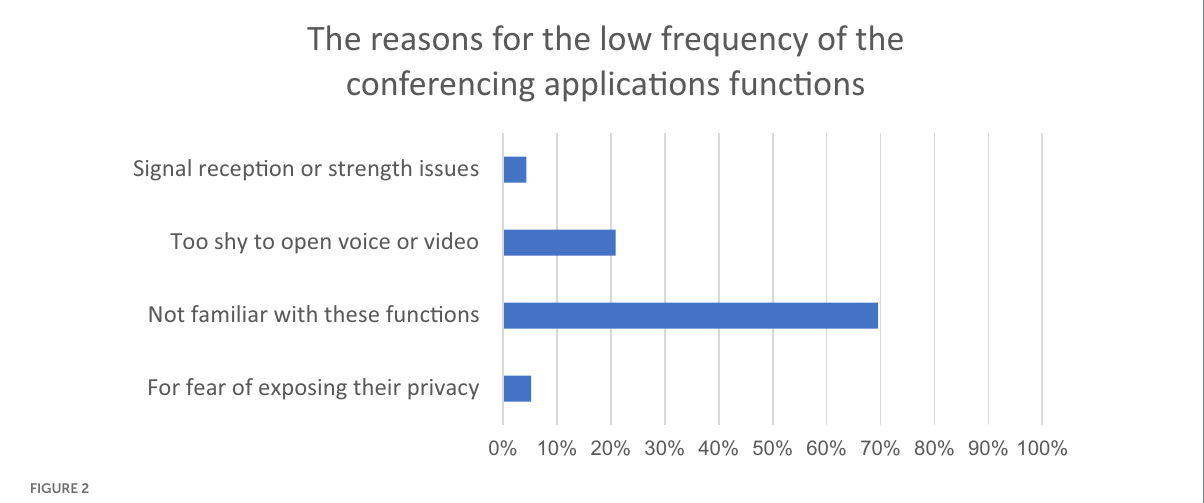
FIGURE 2 Distribution of reasons for the low frequency of the virtual conferencing